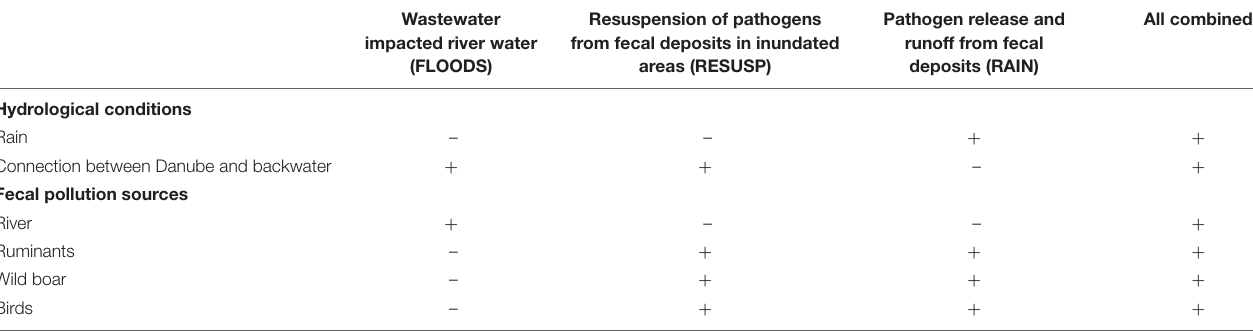
TABLE 4 | Fecal sources and hydrological conditions in the event-driven scenarios investigating (i) the wastewater-impacted river water entering the backwater during floods (FLOODS), (ii) the resuspension of pathogens from fecal deposits in inundated areas (RESUSP), and (iii) the pathogen release and runoff from fecal deposits (RAIN), and (iv) all combined.